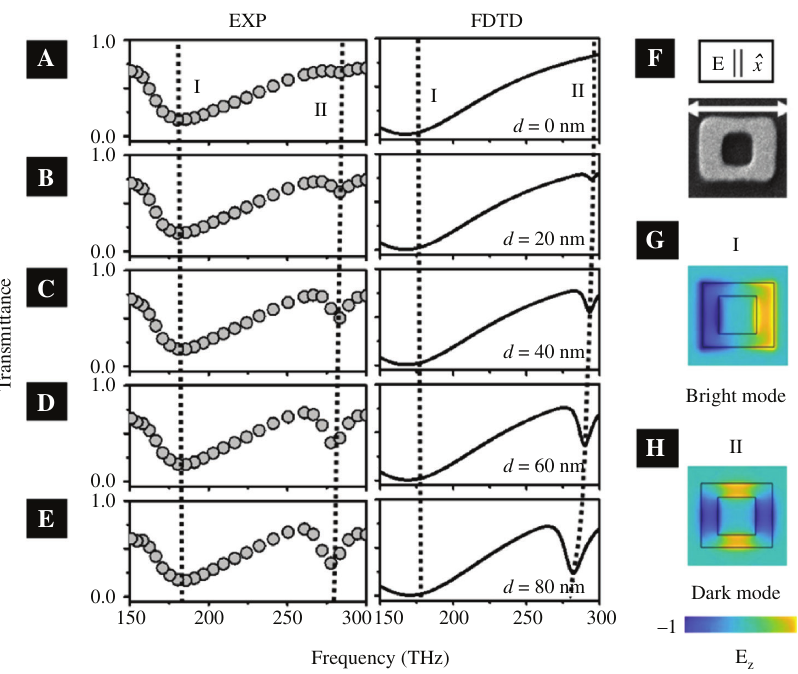
Figure 2: Experimental and numerical results of coupled plasmonic systems for x -polarization. (A–E) Measured (open symbols in the left panels) and simulated (solid black curves in the right panels) transmission spectra of samples ) patterns of the symmetric nanostructure at with different values of d , with (F) x -polarized incident light. (G, H) The simulated Re(E z frequencies corresponding to the dipole mode (labeled as the mode “I”) and the quadrupole mode (labeled as the mode “II”) for x -polarization. Dotted lines represent the resonant frequencies of the bright and dark modes with different values of d for x